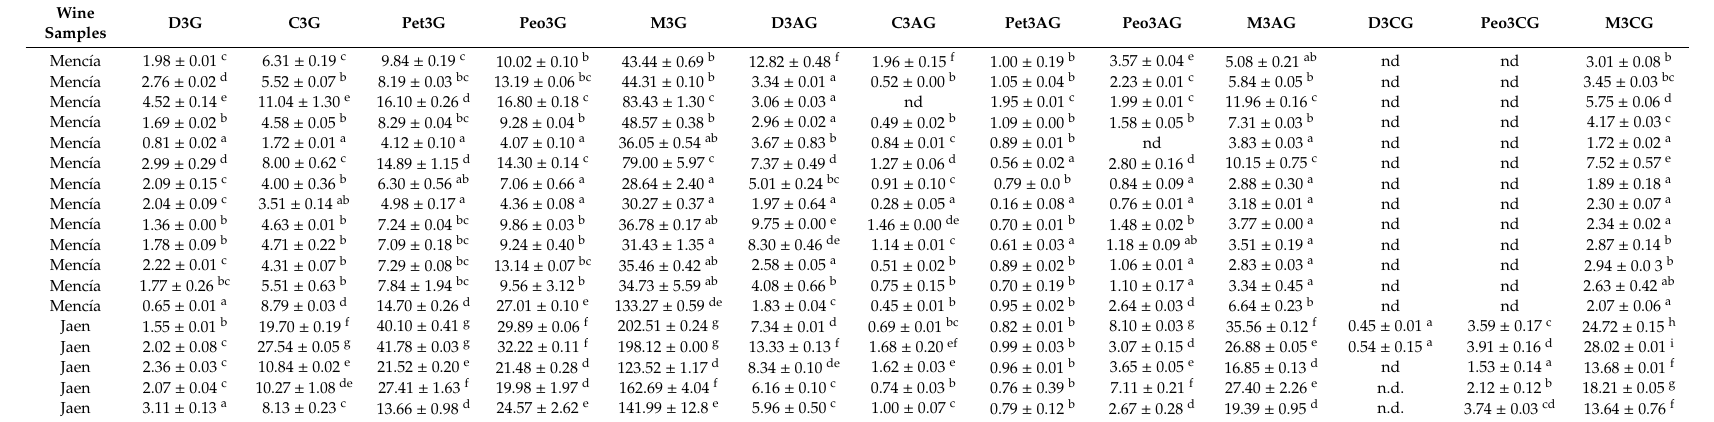
Table 2. ‘Menc í a’ and ‘Jaen’ red wines monomeric anthocyanins profile expressed in mg /